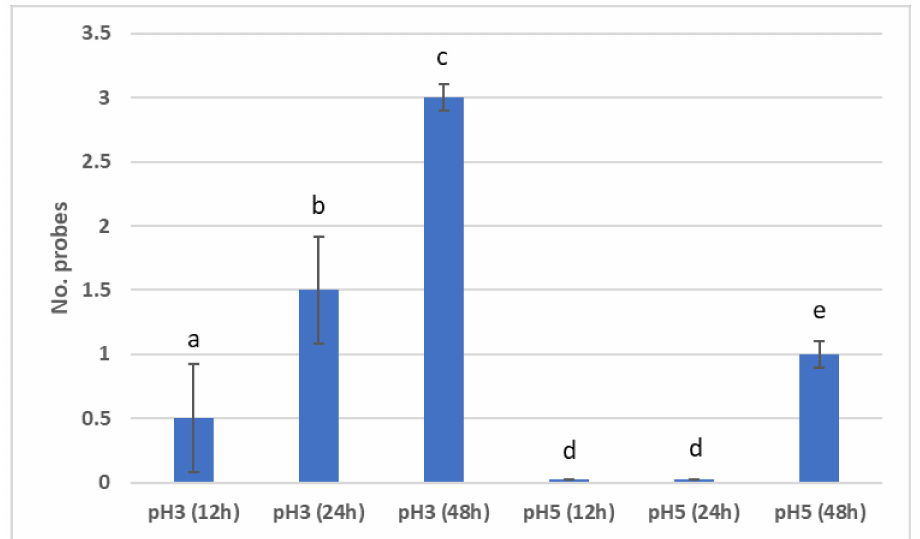
Figure 8. Demineralisation cycles: pH 3 and pH 5. Different letters indicate statistically significant differences p ≤ 0.05 (Duncan’s